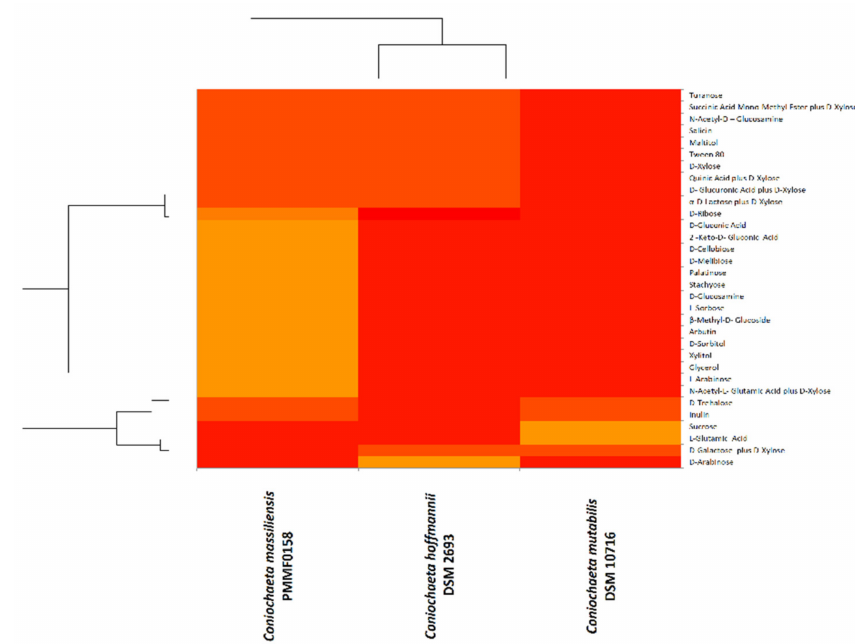
Figure 5. Heat map computed with the XLSTAT software for carbon-source assimilation by the Biolog TM system for the novel species Coniochaeta massiliensis (PMML0158) and two reference strains. Colour-gradient interpretation: the most-assimilated substrates are shown in light orange and the least-assimilated substrates are shown in